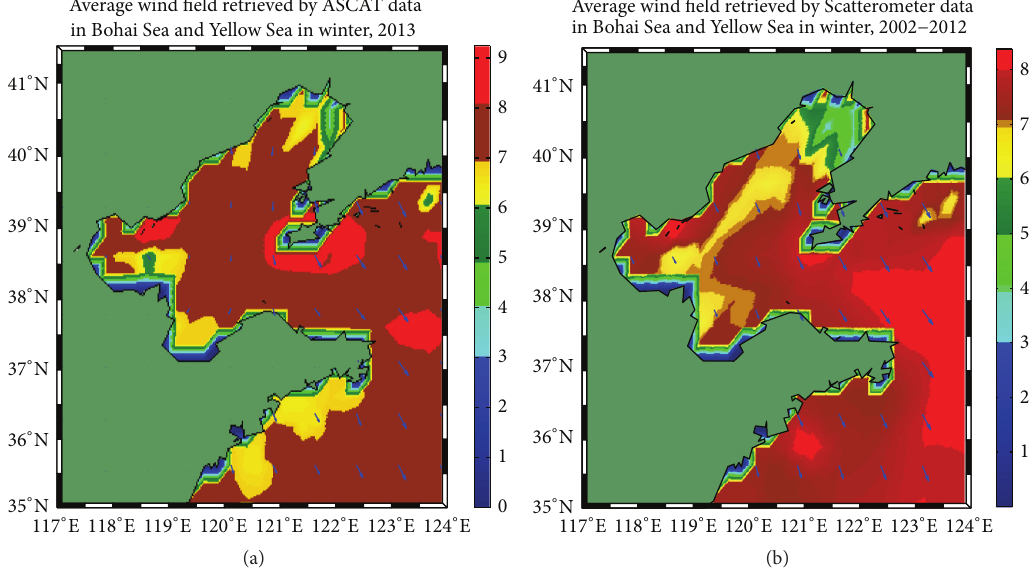
Figure 2: The average wind field retrieved by Scatterometer data in Y-B in winter 2013 (a) and 2002–2012 (b) (unit: m/s).